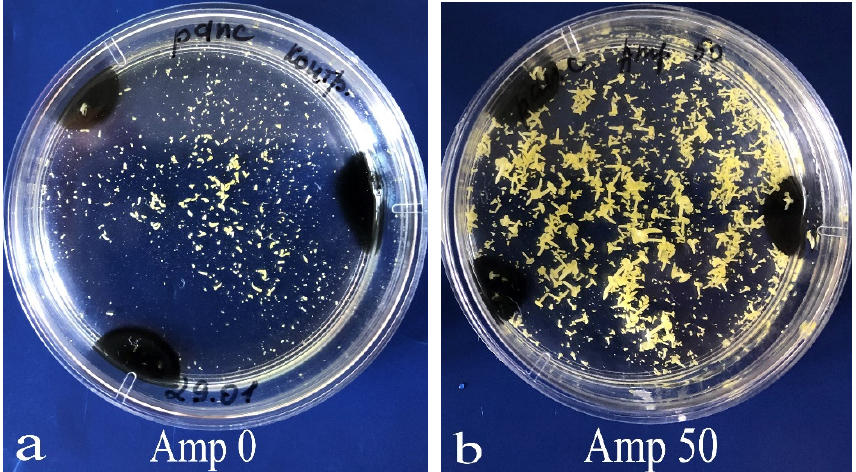
Figure 3. Petri dishes with embryos B. napus on 21 days in a medium ( a ) without antibiotics (embryo development was delayed, perhaps because of bacteria contaminations) and ( b ) with ampicillin (Amp) at a concentration of 50 mg/L.